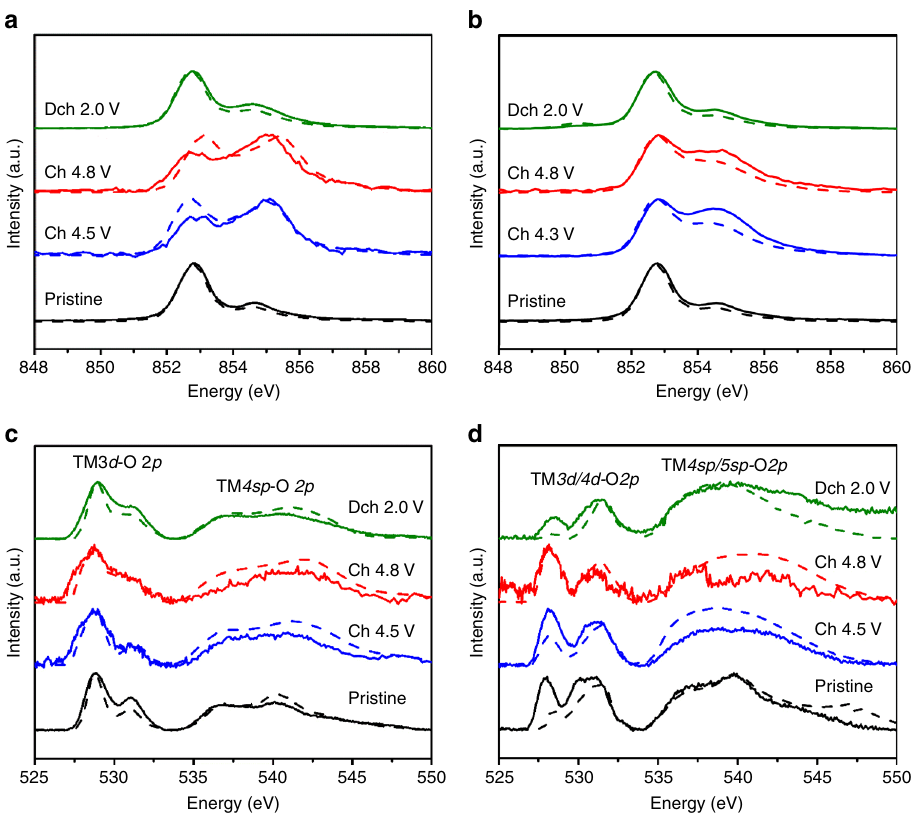
Fig. 4 Electronic structures of Ni and O as probed by sXAS. sXAS Ni L3-edge spectra of a LNMO and b LNRO electrodes; sXAS O K-edge spectra of c LNMO and d LNRO electrodes in FY and TEY modes at different states of charge. Solid and dash line indicate FY and TEY mode,